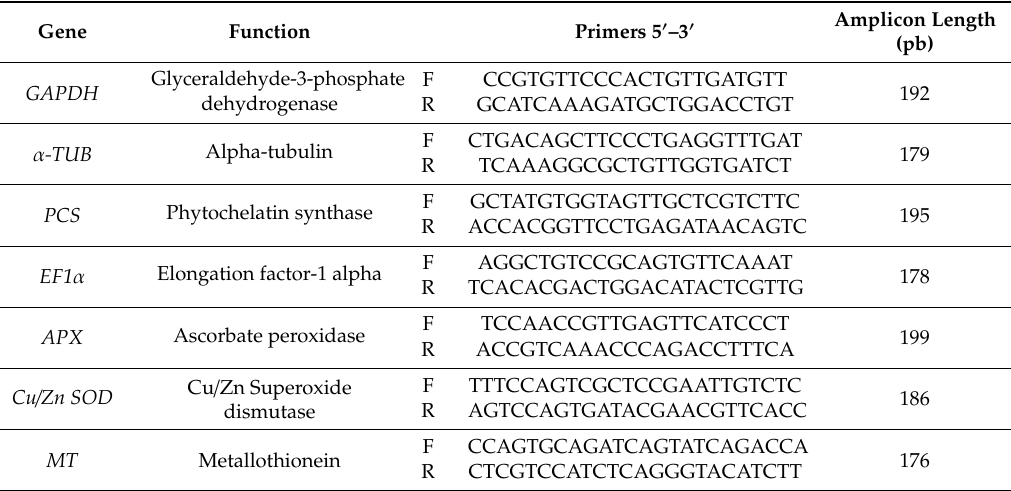
Table 2. Set of primers used for real-time